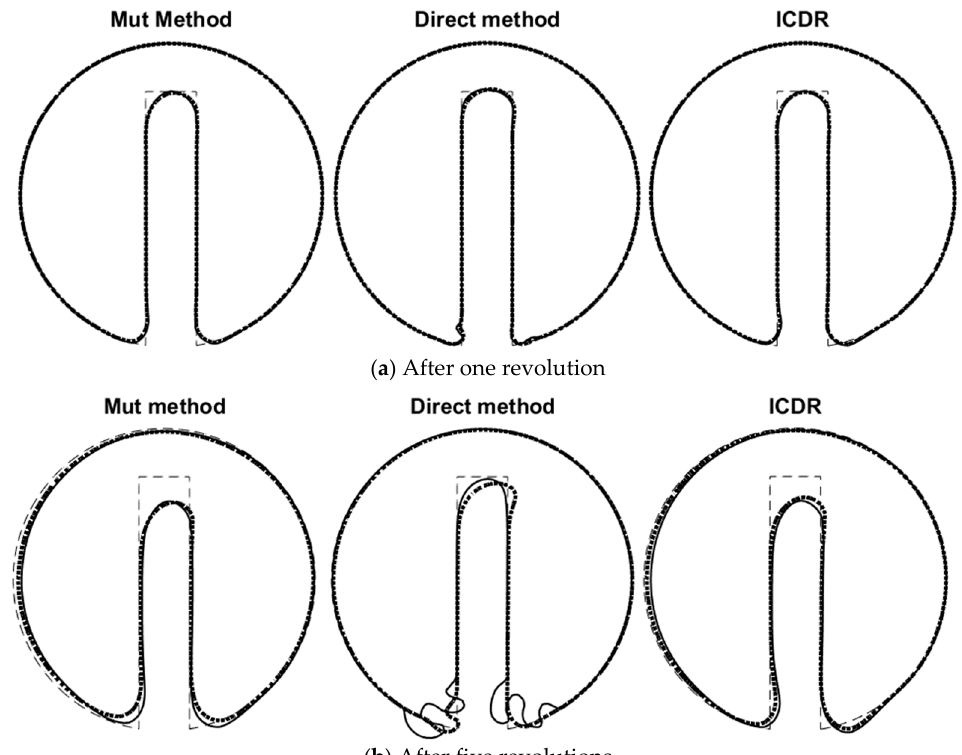
Figure 7. Revolution of the notched cylinder in a N 1 × N 2 = 200 × 200 rectangular domain. In these figures, the dashed line shows the original shape. Also, the solid line and dotted line are the results for ∆ t = 0.5 and ∆ t = 1.0, respectively.